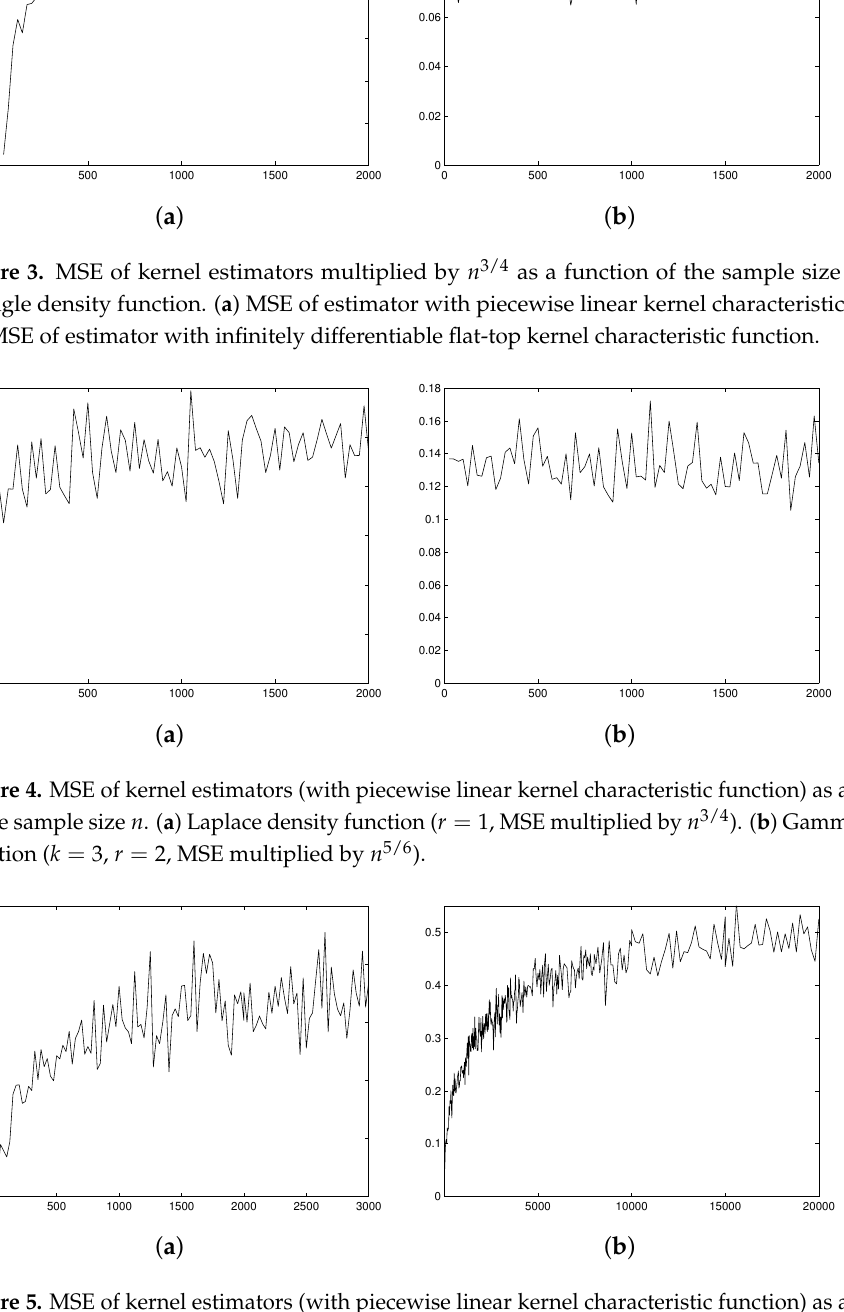
Figure 5. MSE of kernel estimators (with piecewise linear kernel characteristic function) as a function of the sample size n . ( a ) Gamma distribution shape parameter k = 4, r = 3 (MSE multiplied by n 7/8 ). ( b ) Gamma distribution shape parameter k = 6, r = 5 (MSE multiplied by n 11/12 ). Using notation C ( x ) = { 0, x < 0; 1, x ≥ 0 } for Heaviside step function, the triangular density function is defined as f ( x ) = (( λ − | x | ) / λ 2 ) C ( λ − x ) C ( λ + x ) having character- istic function φ ( s ) = 2 ( 1 − cos ( λ s )) / ( λ s ) 2 . Laplace density f ( x ) = λ /2 exp ( − λ | x | ) has characteristic function φ ( s ) = λ 2 / ( λ 2 + s 2 ) , gamma density f ( x ) = λ k x k − 1 e − λ x / Γ ( k ) has characteristic function φ ( s ) = λ k / ( λ − is ) k